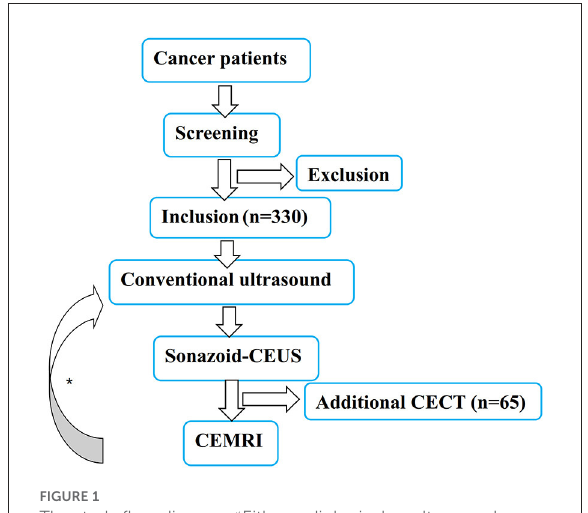
FIGURE1 The study flow diagram. * Either radiological or ultrasound examination start first is OK.